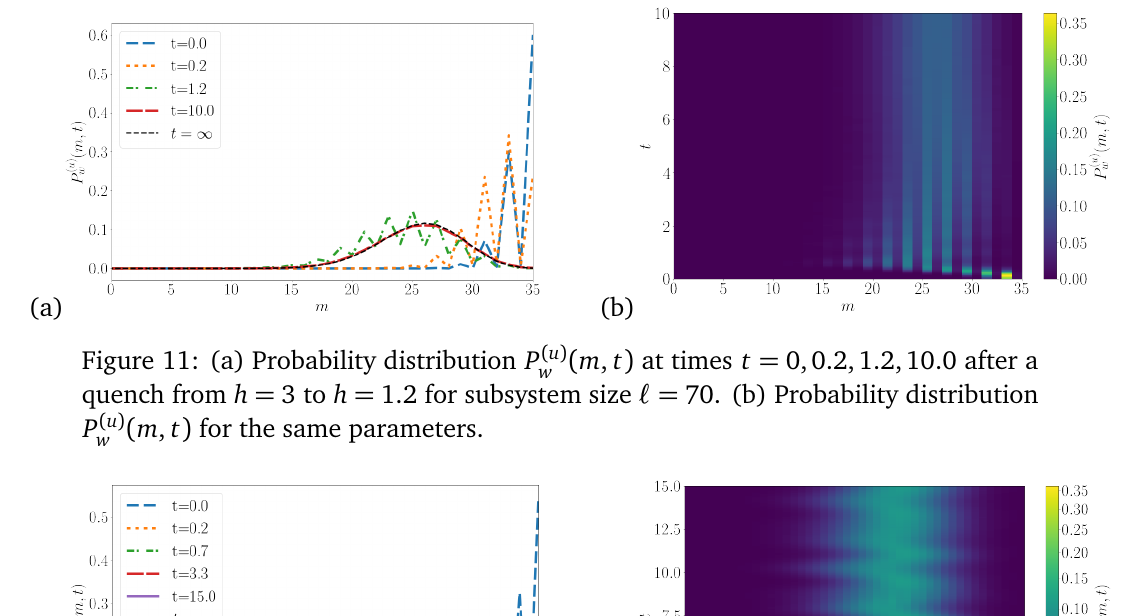
Figure 10: (a) Probability distribution P ( u ) quench from h = 0.2 to h = 0.8 for subsystem size (cid:96) = 70. (b) Probability distribution ( m , t ) for the same parameters. P ( u ) w